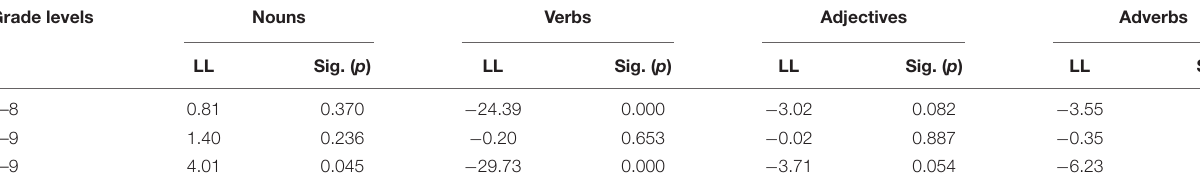
TABLE 7 | Log-likelihood (LL) tests for lexical word classes across grade levels.